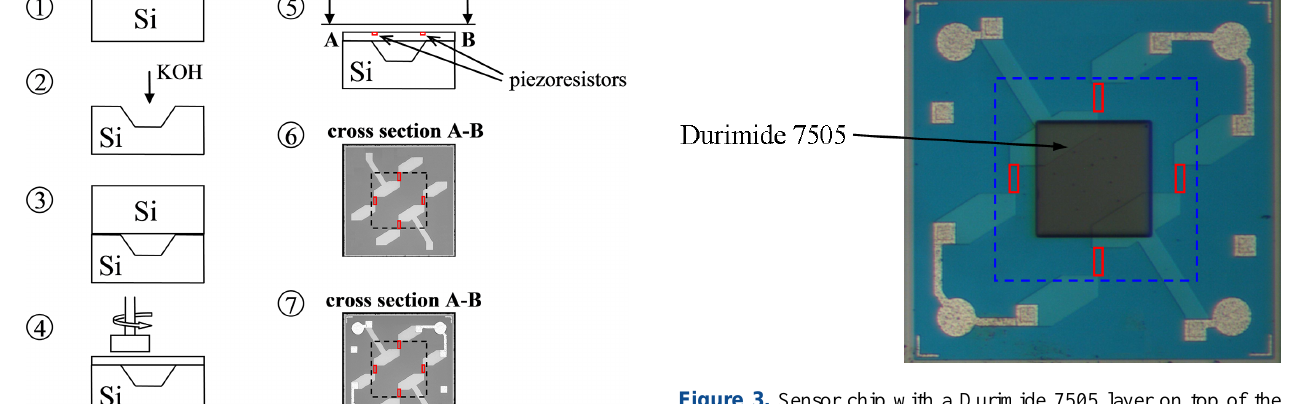
Figure 3. Sensor chip with a Durimide 7505 layer on top of the diaphragm. The patch has a size of 300 × 300µm and a thickness of